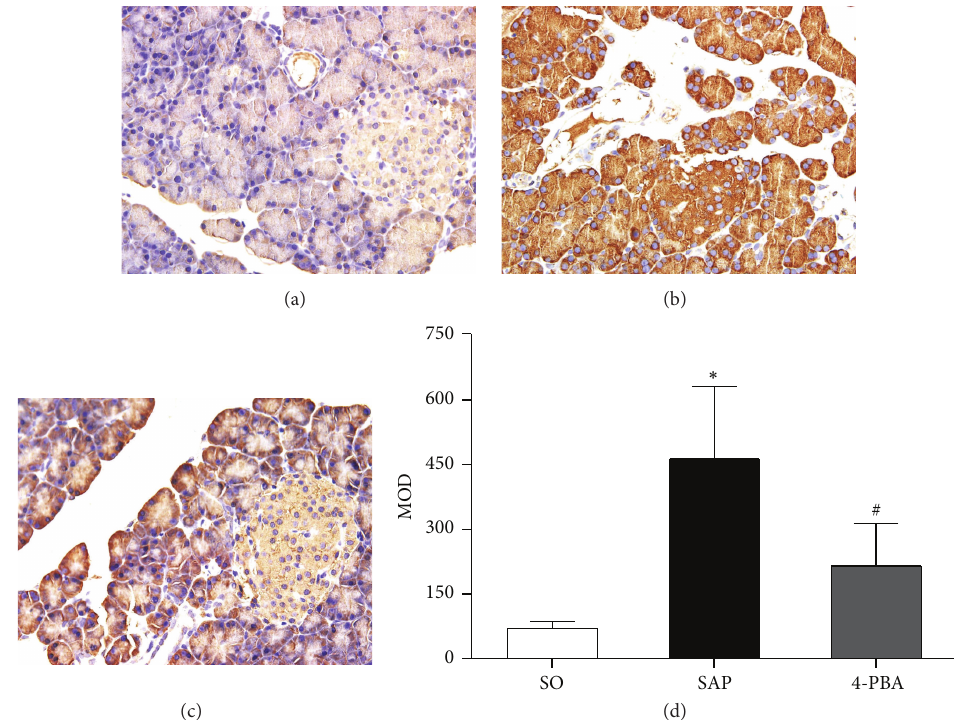
Figure 6: Immunohistochemical expression of BiP in pancreatic islets (original magnification, × 400). (a) SO group; (b) SAP group; (c) 4-PBA group. (d) Comparison of mean optical density (MOD) of BiP in all groups. Each value represents the mean ± standard deviation. ∗ 𝑃 < 0.05 versus SO group; # 𝑃 < 0.05 versus SAP